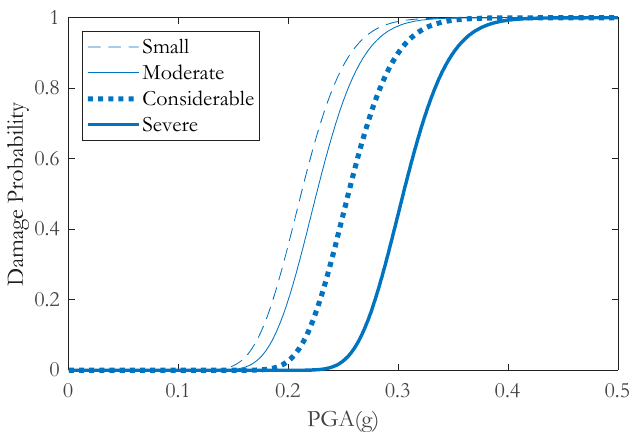
Figure 8. Fragility curves of four levels of damage state without any scour effects.